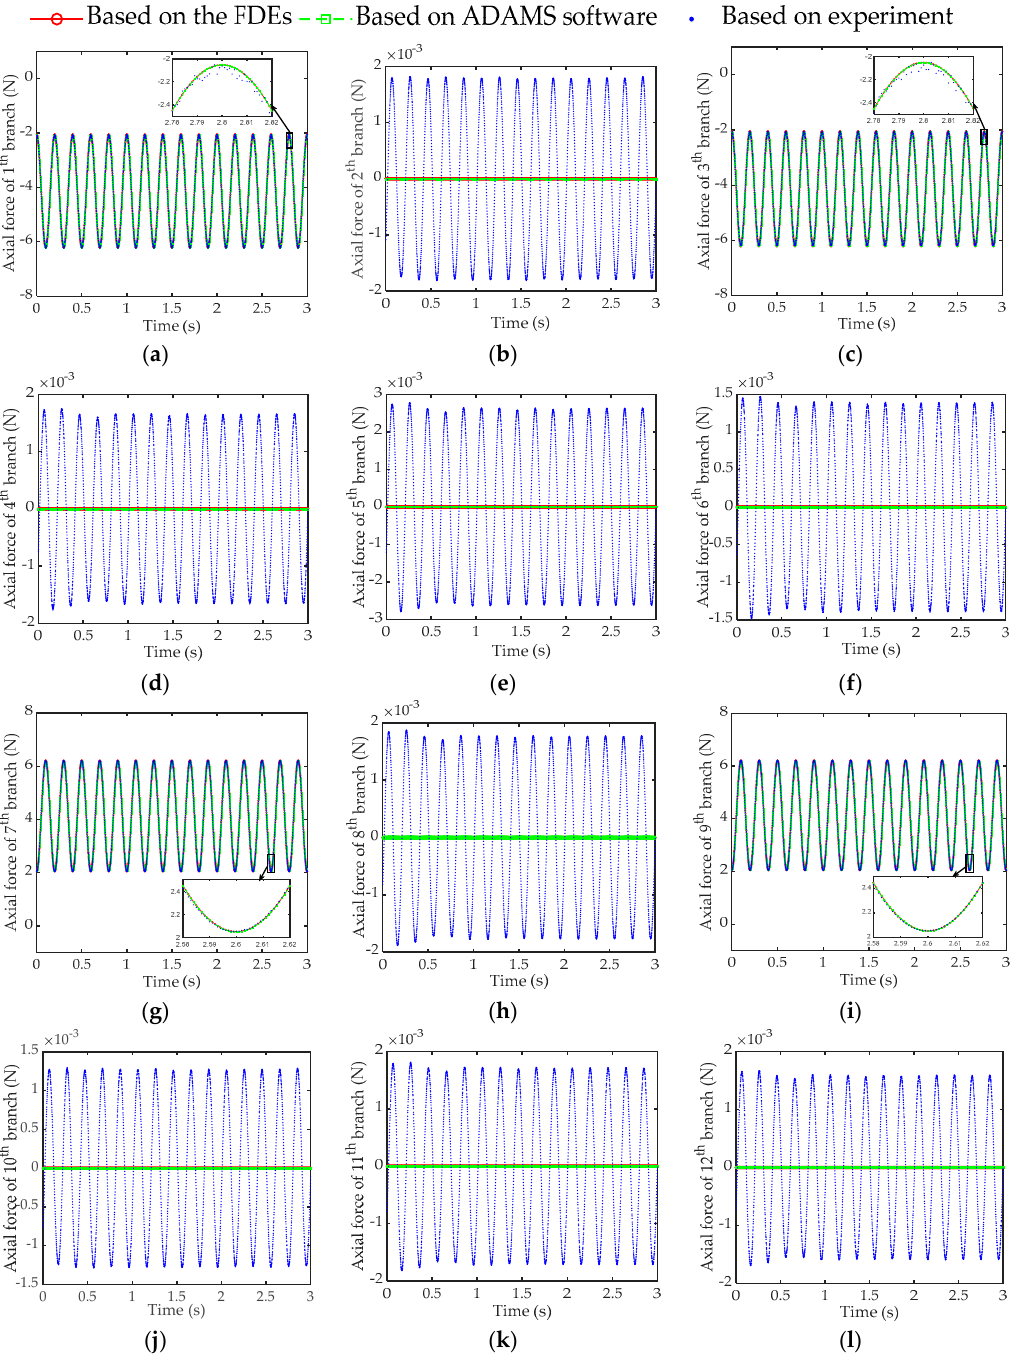
Figure 10. Comparison diagram of axial force calculated by three methods. ( a ) 1st branch; ( b ) 2nd branch; ( c ) 3rd branch; Substituting the axial forces obtained by the three methods in Figure 10 into the IDEs of this article, the calculation results of acceleration are shown in Figure 11, respectively. Then, based on Figure 11, combining Equation (39) with the measurement result of IMU, the solution error of the IDEs of the sensor is shown in Figure 12.